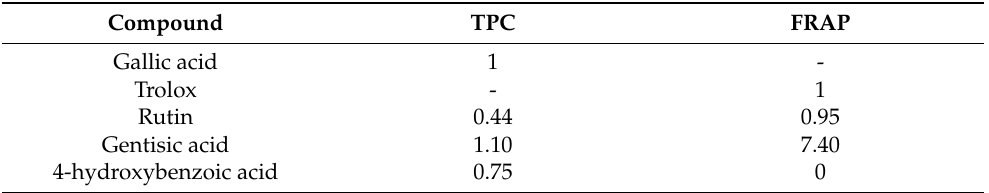
Table 7. The slope of the TPC and FRAP calibrations for the main phenolic compounds identified in noni juice samples, relative to the respective standards (gallic acid for TPC or Trolox for FRAP). Compound TPC FRAP Gallic acid 1 - Trolox - 1 Rutin 0.44 0.95 Gentisic acid 1.10 7.40 4-hydroxybenzoic acid 0.75